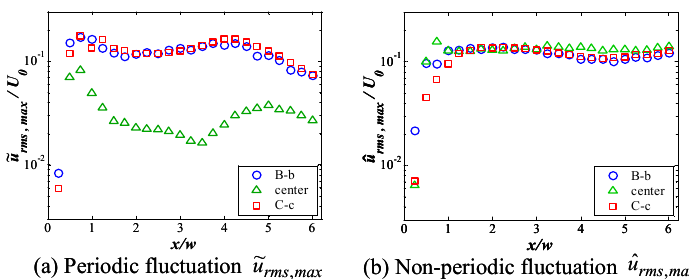
(b) Non-periodic fluctuation (a) Periodic fluctuation